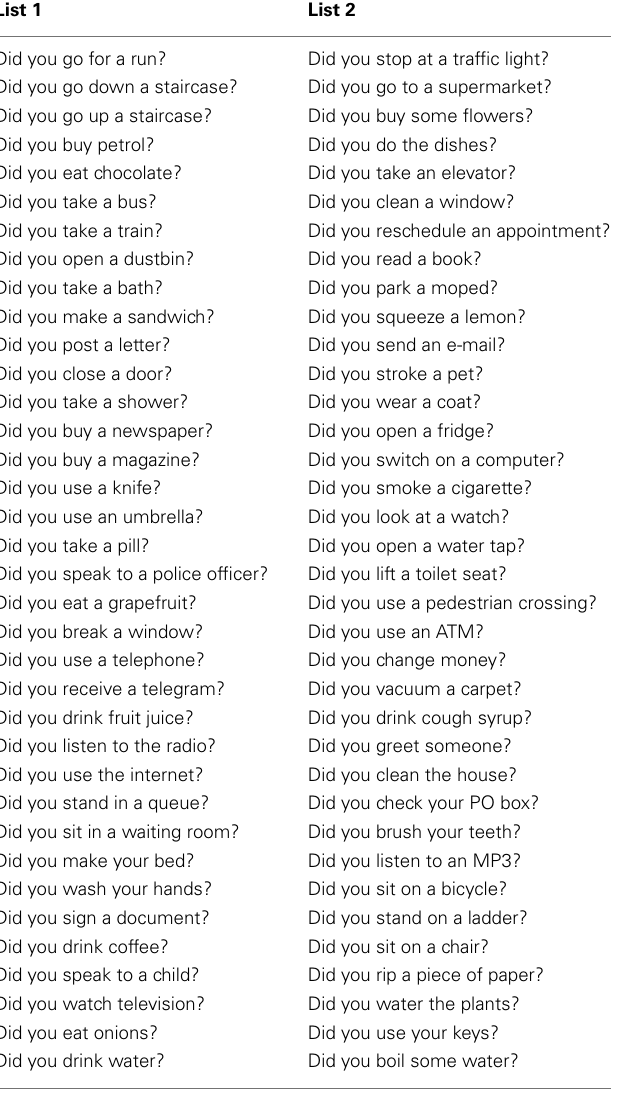
used as either filler or test items (counterbalanced) in the